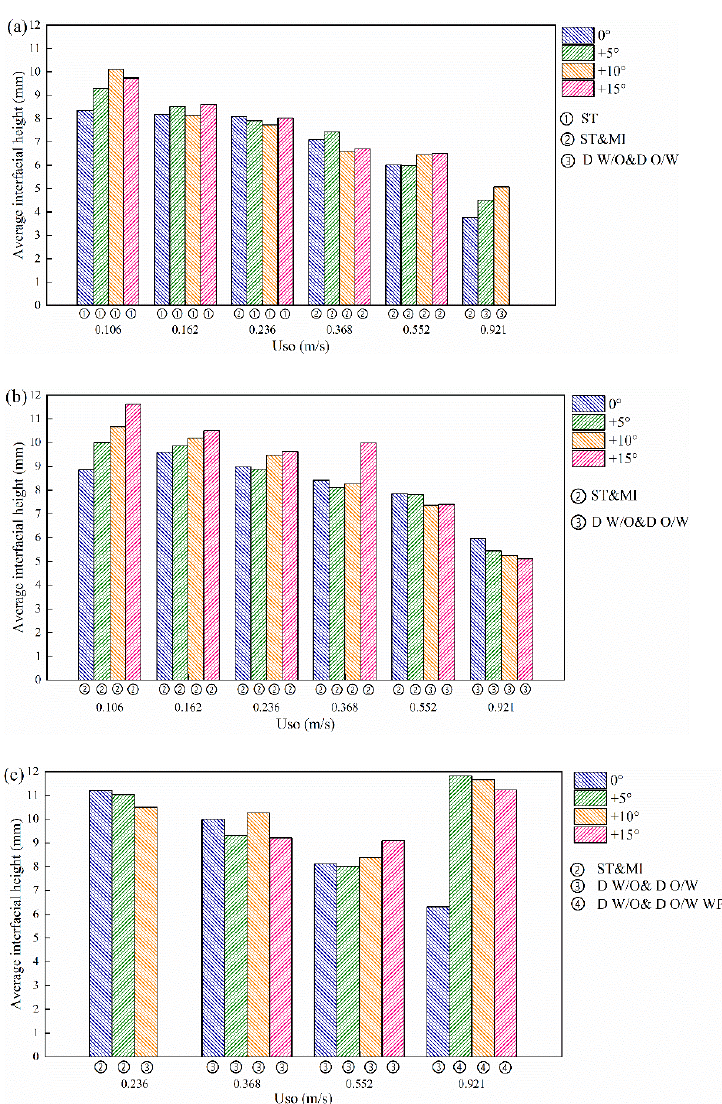
Figure 21. Average interfacial height under typical flow conditions. ( a ) U sw = 0.184 m/s; ( b ) U sw = 0.368 m/s; ( c ) U sw = 0.737 m/s.